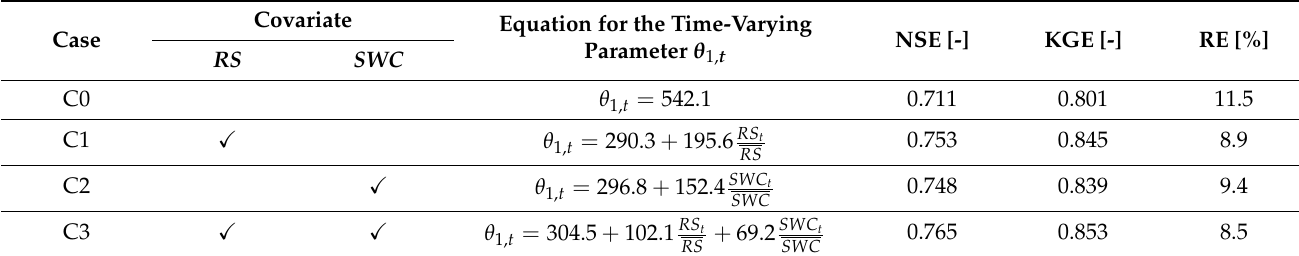
Table 2. Model evaluation and selection for the nonstationary GR4J model (model 2).